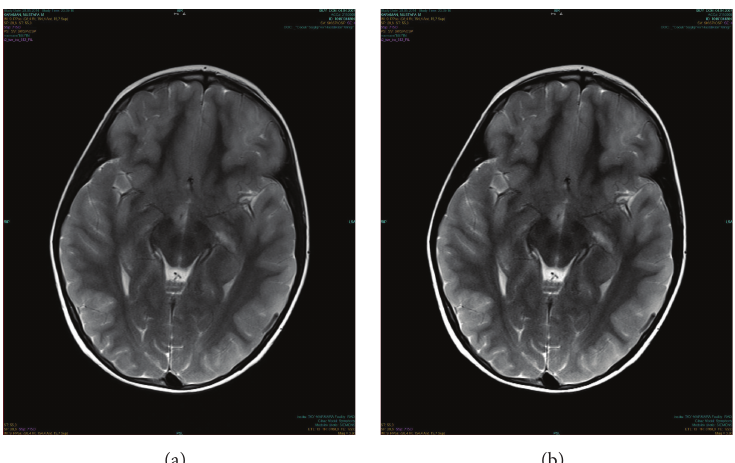
Figure 1: (a, b) Contrast enhancement in the posterior side of the bilateral insular cortex, right hypothalamus, and inferior left frontal cortex consistent with encephalitis.